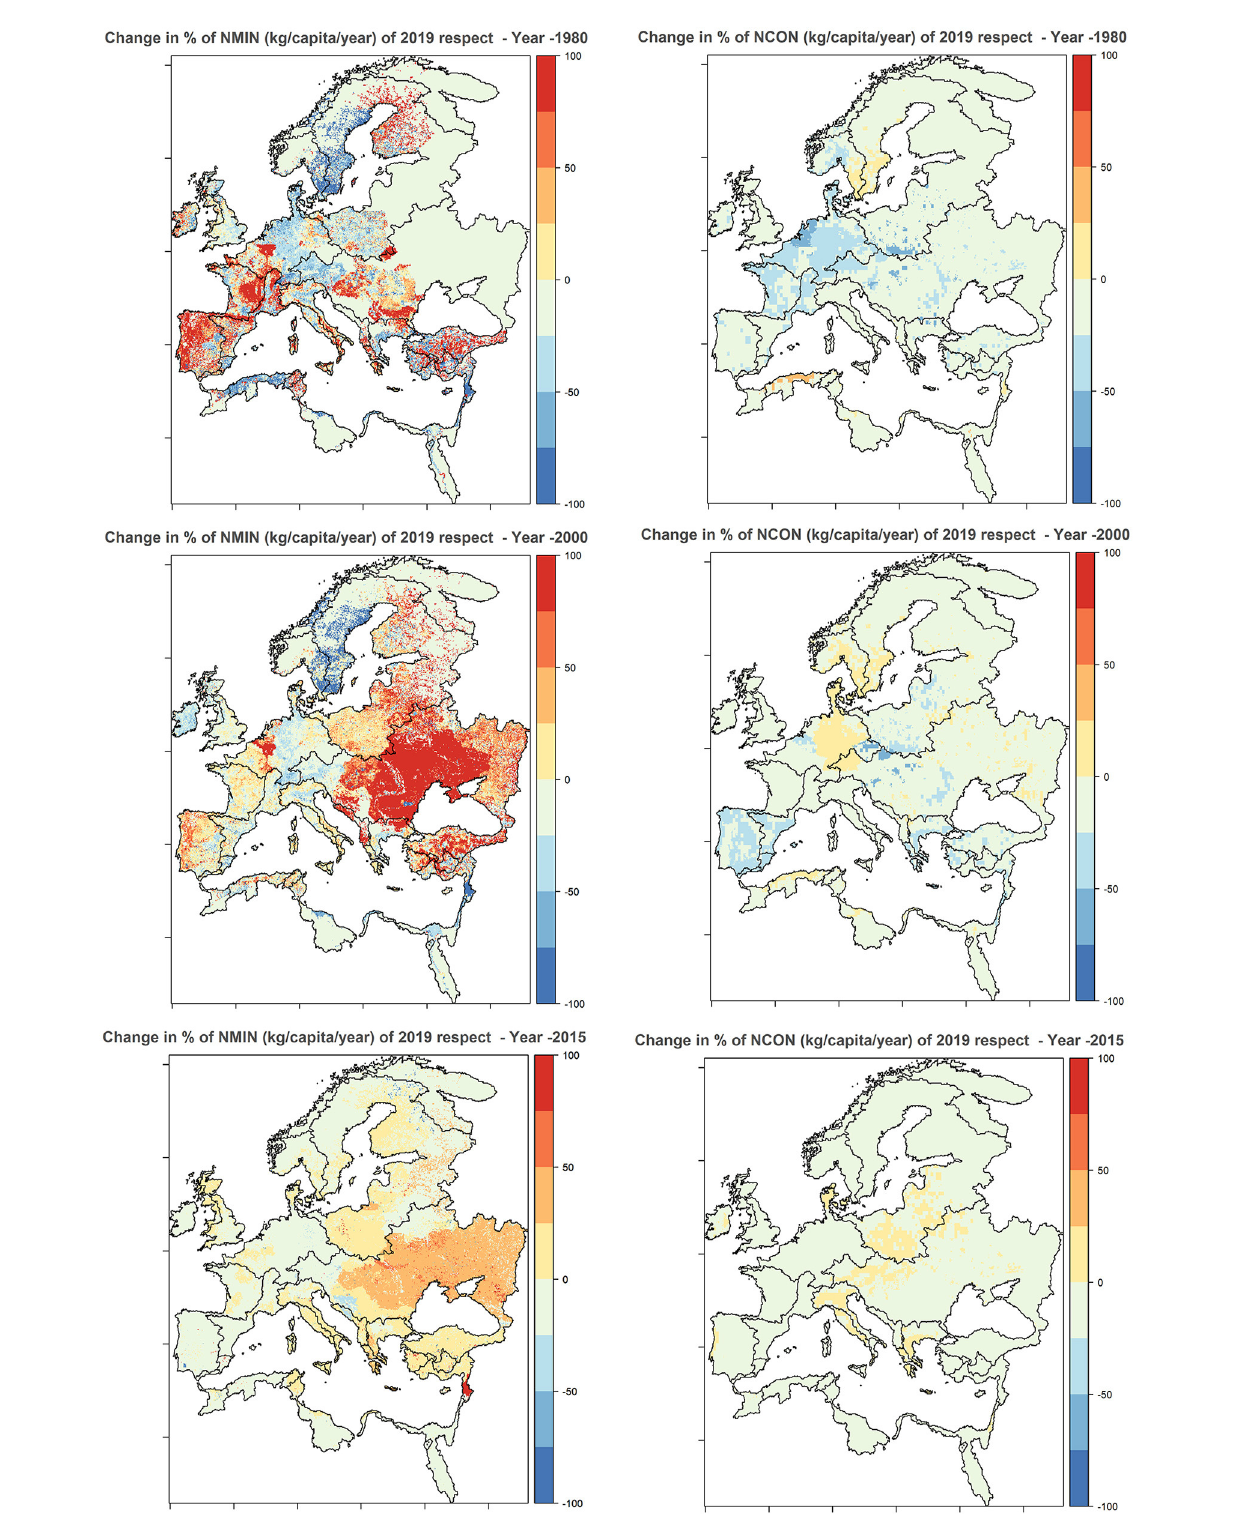
FIGURE3 On the left , spatial variation of changes (%) of N mineral fertilizer (kg/capita) in the year 2019 with respect to 1980, 2000, and 2015. On the right , spatial variation of changes (%) of N emissions collected in sewerage systems (kg/capita) in the year 2019 with respect to 1980, 2000, and